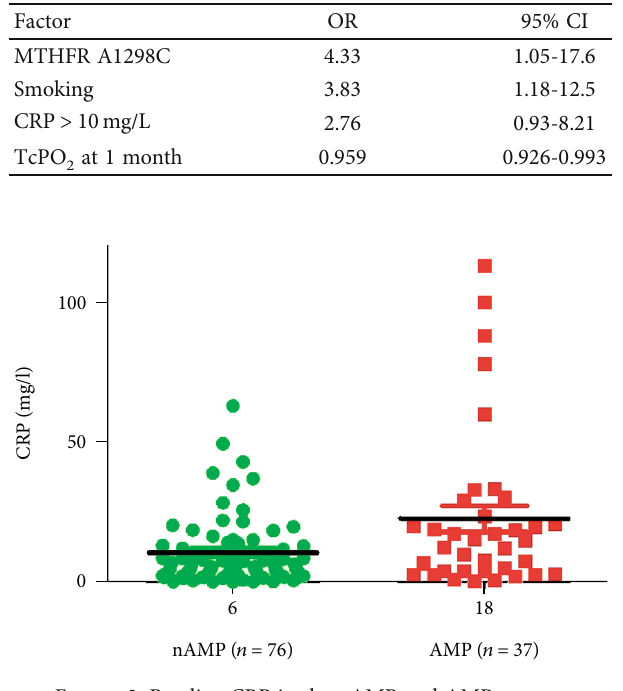
Figure 2: Baseline CRP in the nAMP and AMP groups.